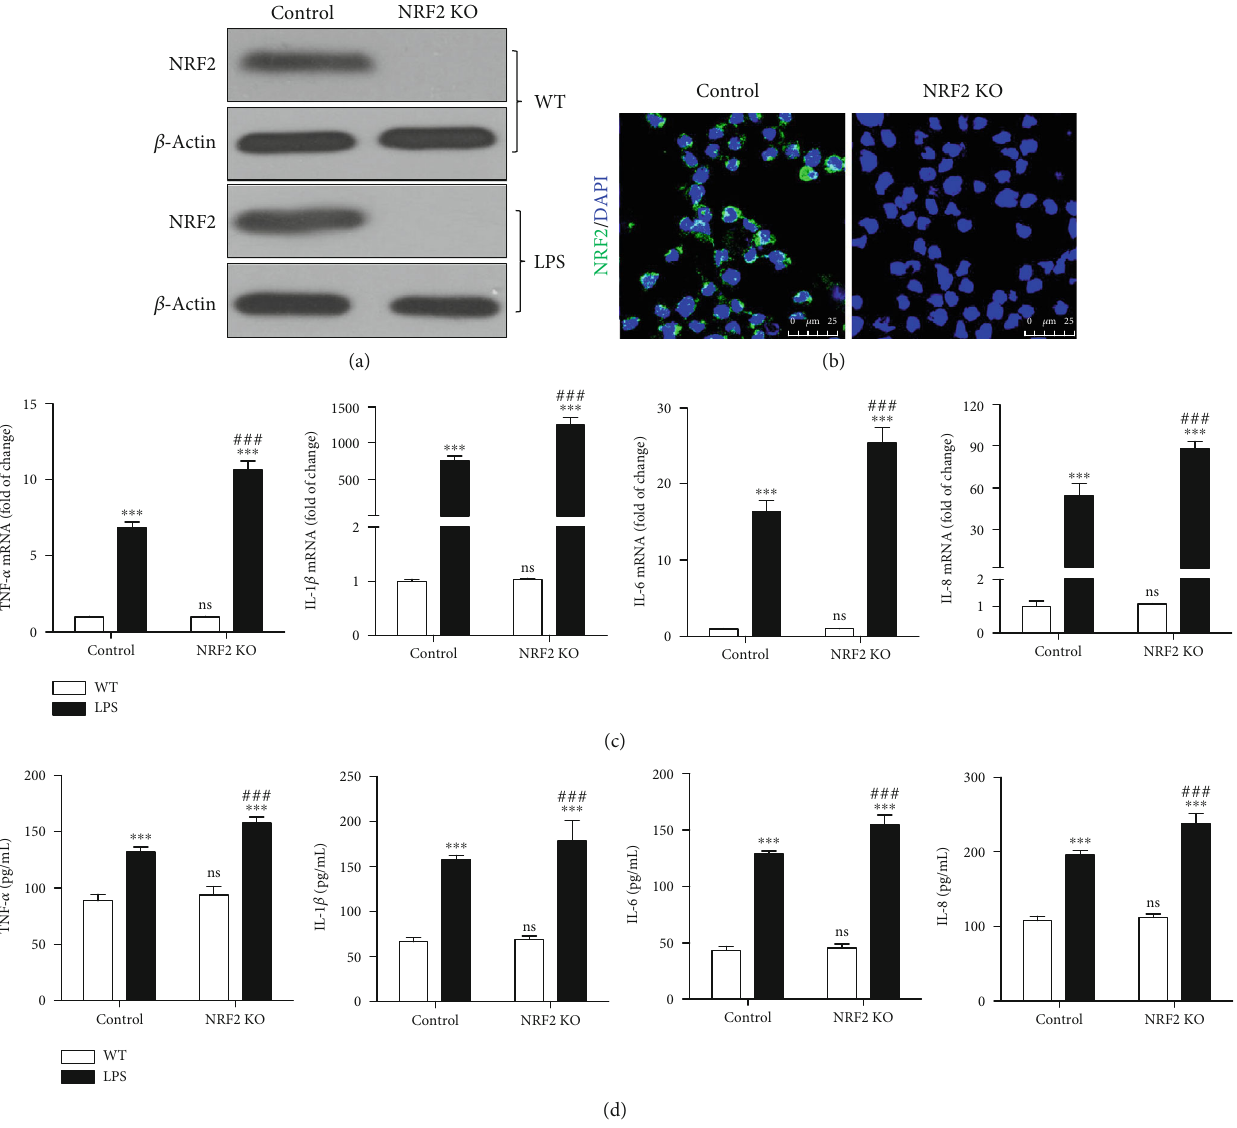
Figure 3: Depleting NRF2 increased LPS-induced proin fl ammatory cytokines expression. Control and NRF2 knockout (KO) gEECs were stimulated with or without 8 μ g/mL LPS for 12 hours and then (a) detected the NRF2 protein expression by immunoblotting. (b) The dynamic changes of cytoplasmic and nuclear NRF2 were imaged by immuno fl uorensent staining. (c) RT-qPCR analysis of the indicated TNF- α , IL-1 β , IL-6, and IL-8 mRNA expression. (d) The concentrations of proin fl ammatory cytokines (TNF- α , IL-1 β , IL-6, and IL-8) in culture medium were determined with ELISA. Data shown are mean ± SD ; ns was P > 0.05, and ### was P < 0 : 001 vs. control group; ∗∗∗ was P < 0 : 001 vs. WT group. P value was calculated by the one-way ANOVA with Tukey ’ s test as a posthoc test. Scale bar was 45 μ